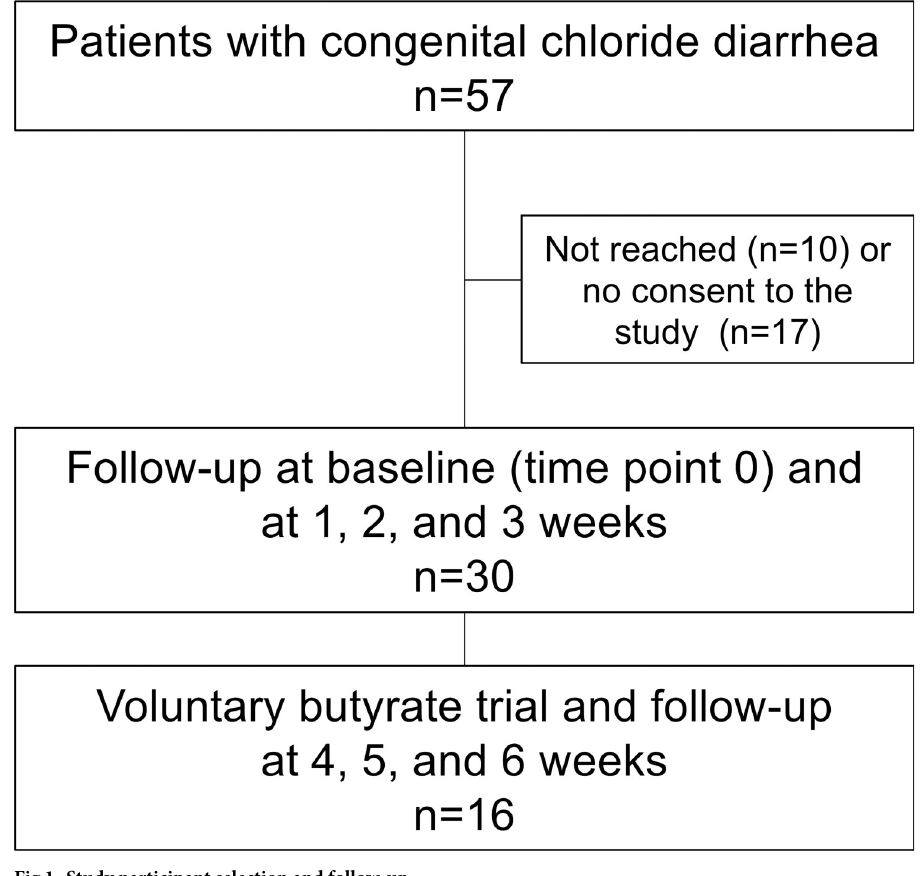
Fig 1. Study participant selection and